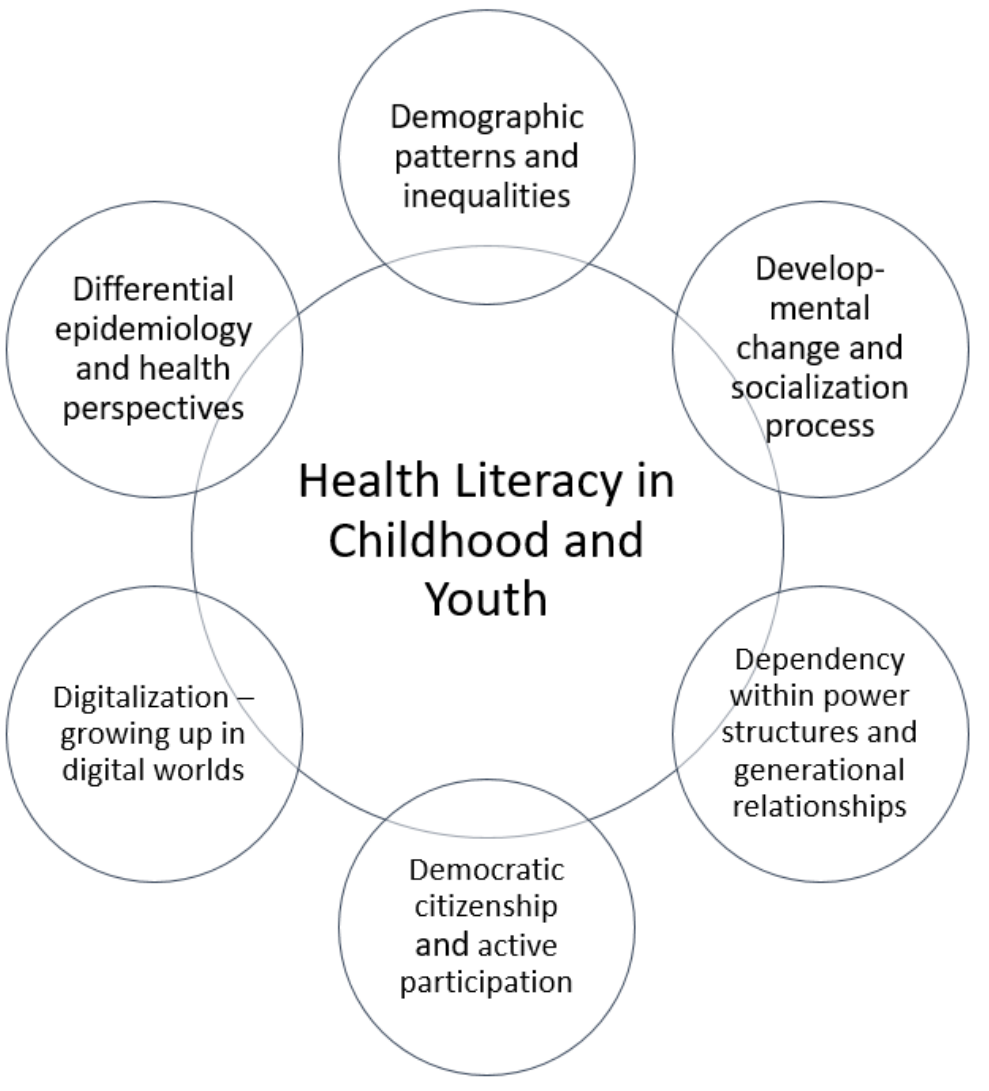
Figure 1. Health literacy 6-D model, highlighting six target-group-oriented health literacy dimen- sions.